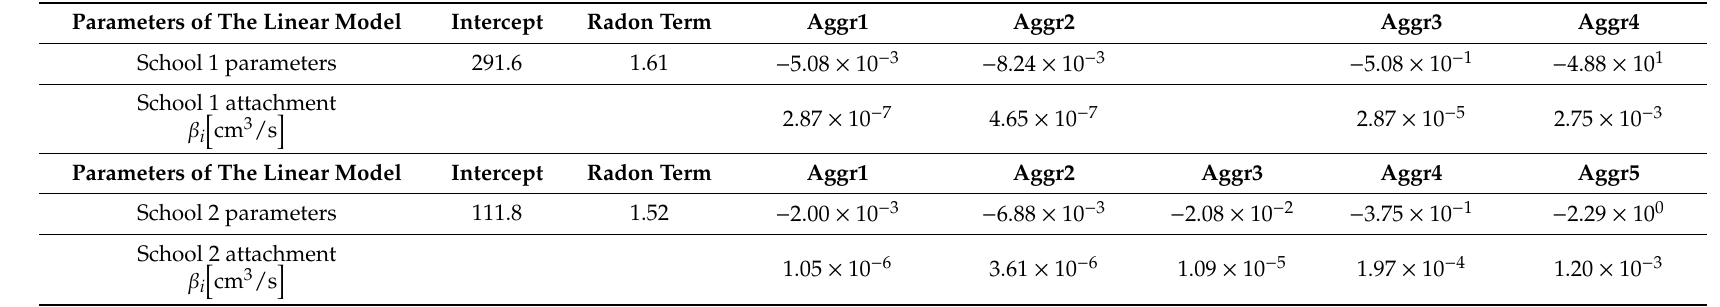
Table 3. Linear model based on Equation (6), with radon as a proxy for volumetric rate and aggregated particle